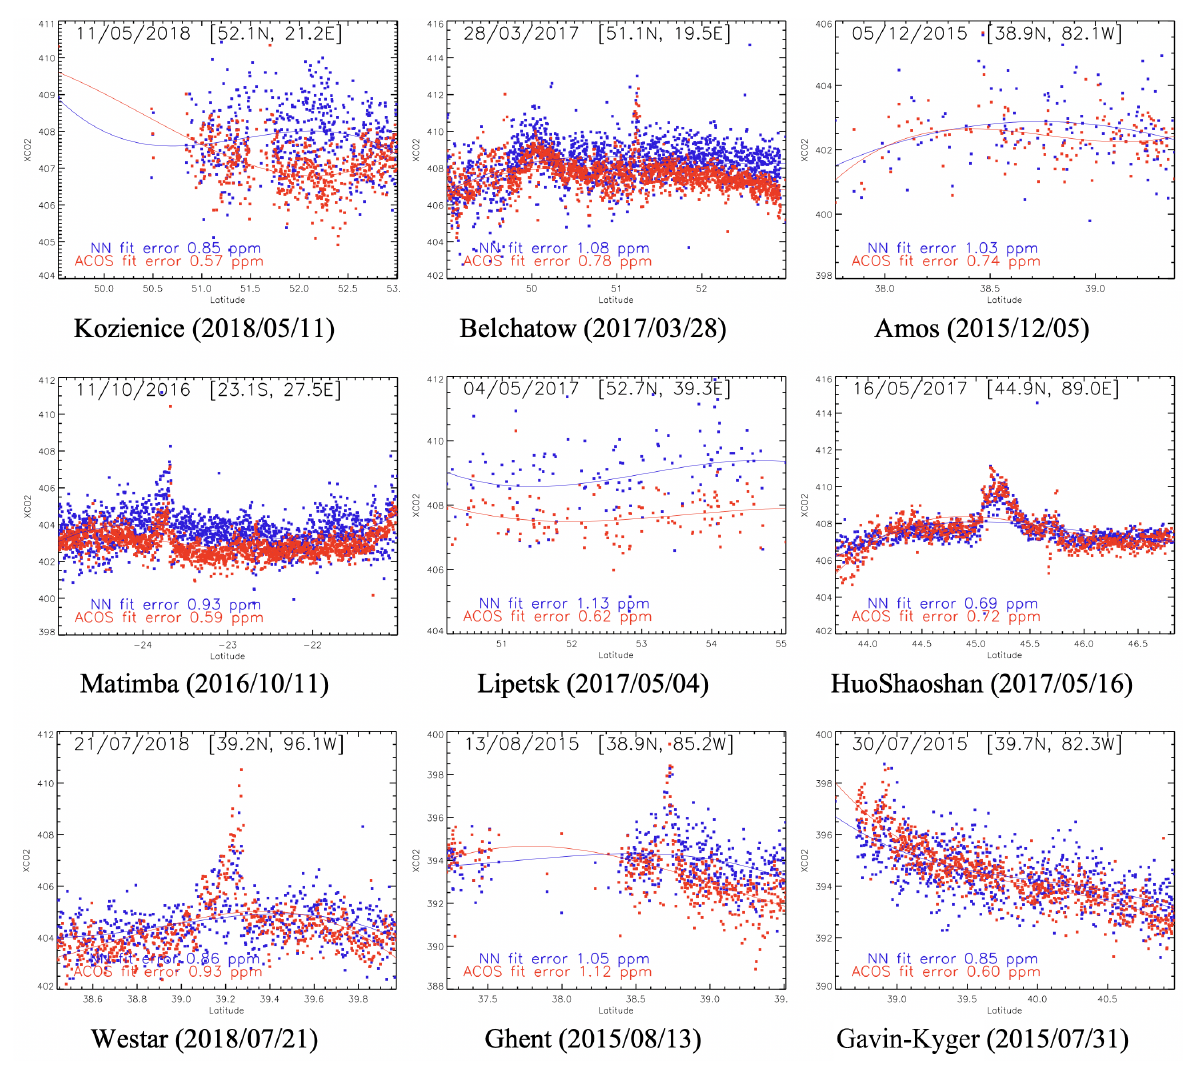
Figure A4. Examples of anthropogenic CO 2 plumes as seen by the OCO2 instrument processed with the ACOS algorithm (red) and the neural network described in this paper (blue). The cases have been identified and described in Reuter et al. (2019) and Nassar et al.